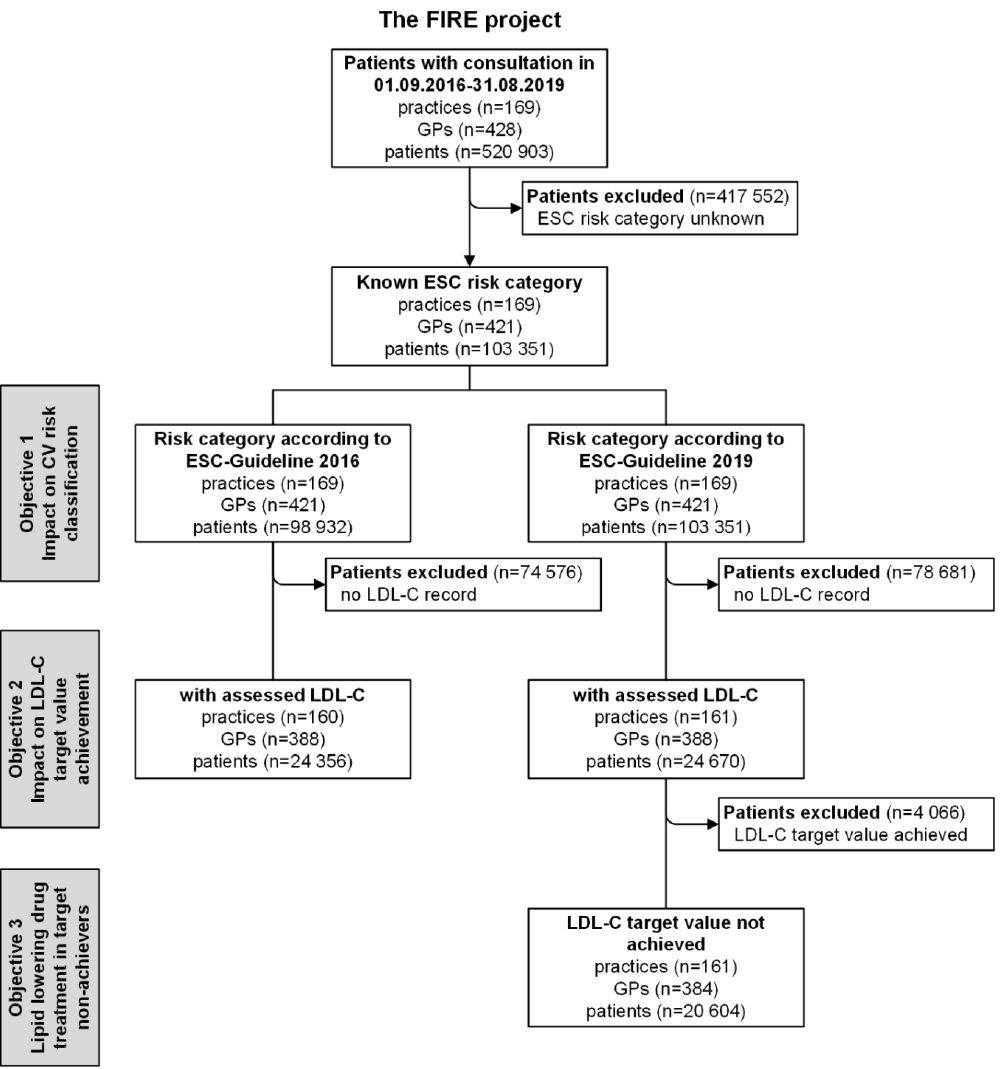
Figure 1. Flowchart of study protocol. GPs: general practitioners; ESC: European Society of Cardiology; LDL-C: low-density lipoprotein cholesterol.